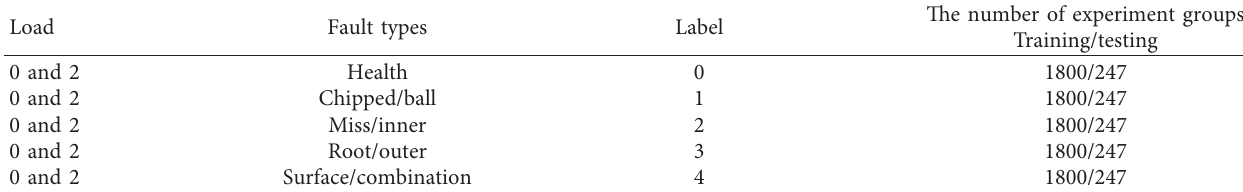
Table 2: The experimental data grouping situation.